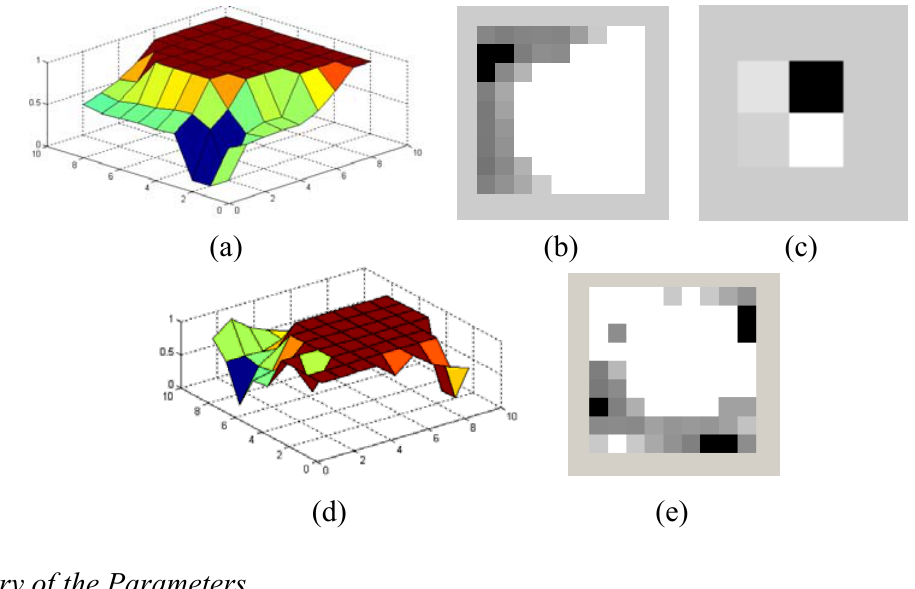
Figure 8. Process of WTDS with guided walk mutation ( a ) The QoC matrix of the sub-region before mutation; ( b ) The grayscale representation of the QoC matrix; ( c ) The approximation matrix after WT; ( d ) The QoC matrix of the sub-region after mutation; ( e ) The grayscale representation of the QoC matrix after mutation.